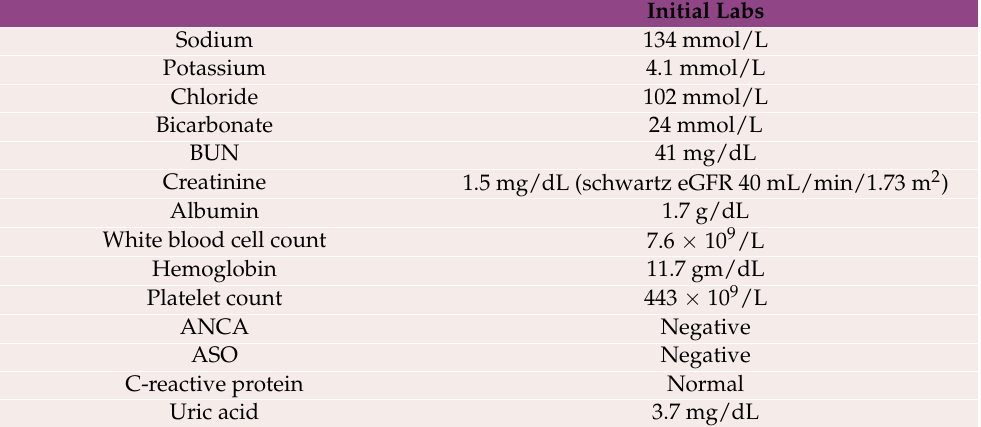
Table 1. Laboratory values. ANCA, anti-neutrophil cytoplasmic antibody; ASO, anti-streptolysin O; BUN, blood urea nitrogen; eGFR, estimated glomerular filtration rate.